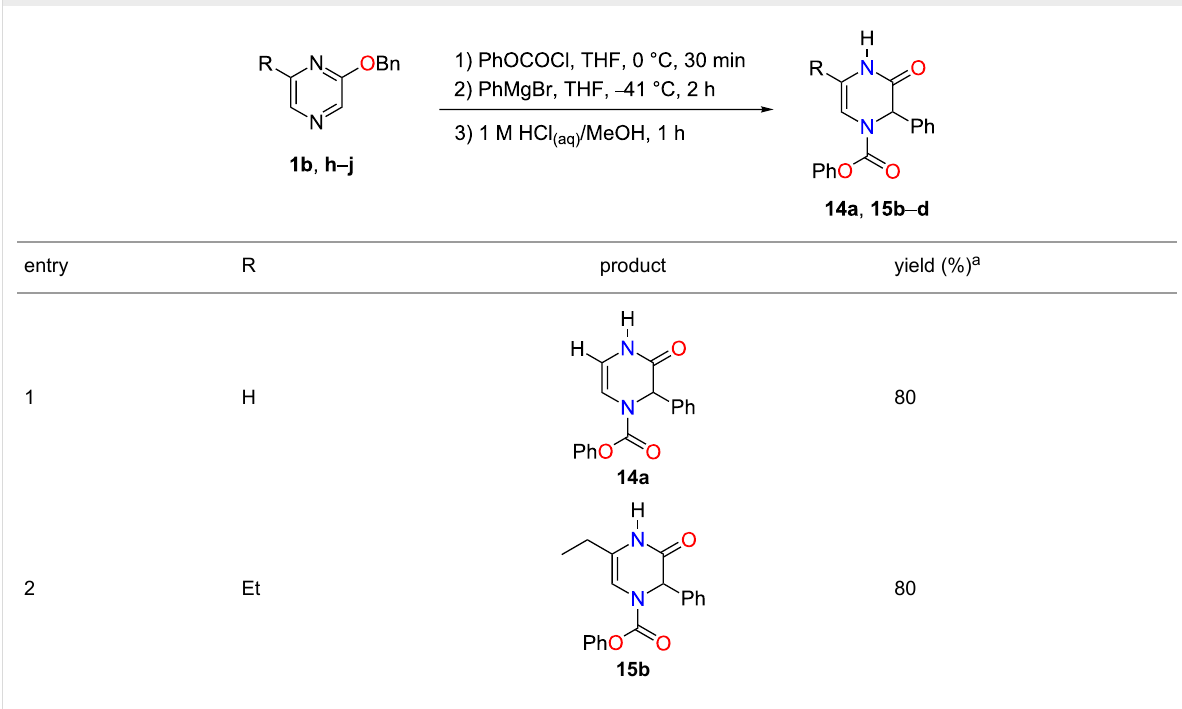
Table 3: One-pot synthesis of substituted Δ 5 -2-oxopiperazines.